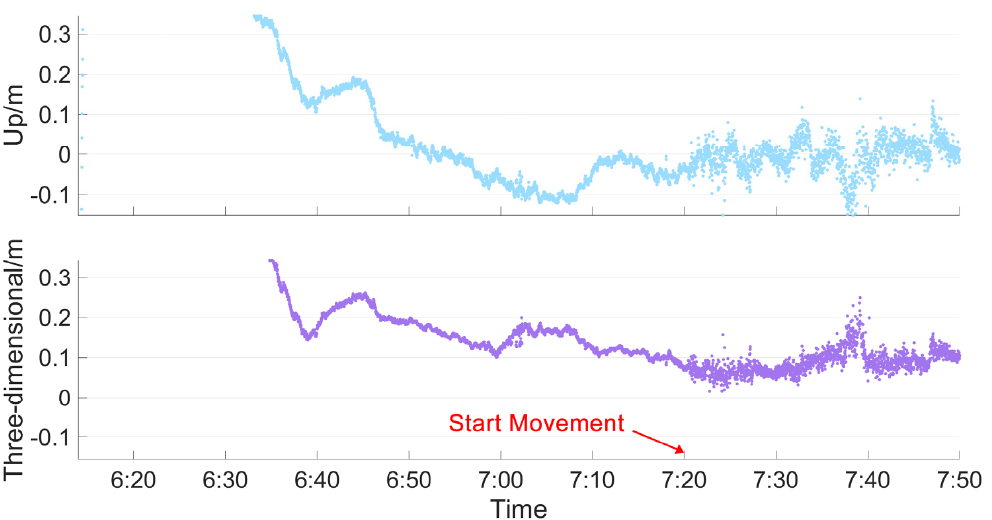
Figure 15. Real-time PPP-B2b positioning accuracy in kinematic mode, including PPP-B2b service interruptions.